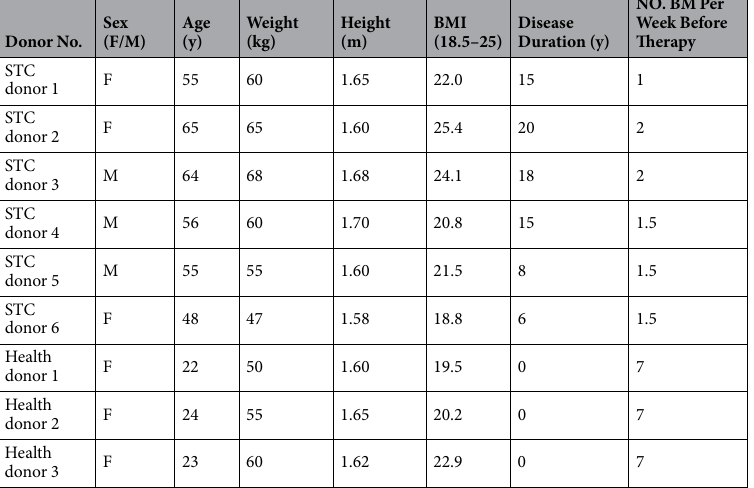
Table 1. Clinical characteristics of included donors at baseline (Healthy donor = 3, STC donor = 6). F,